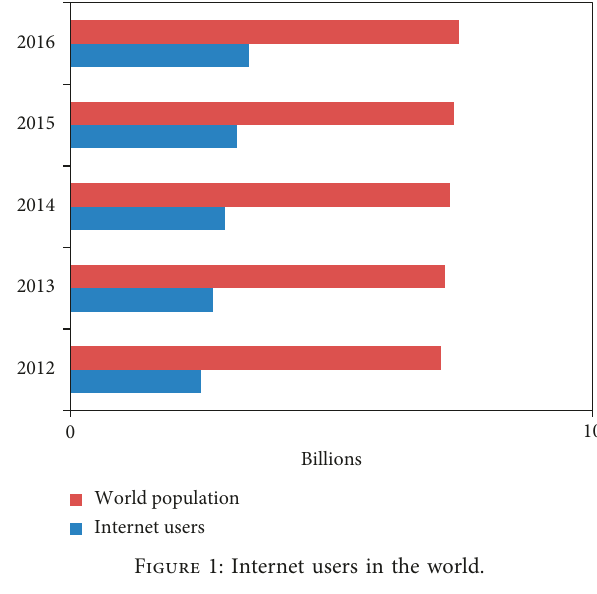
Figure 1: Internet users in the